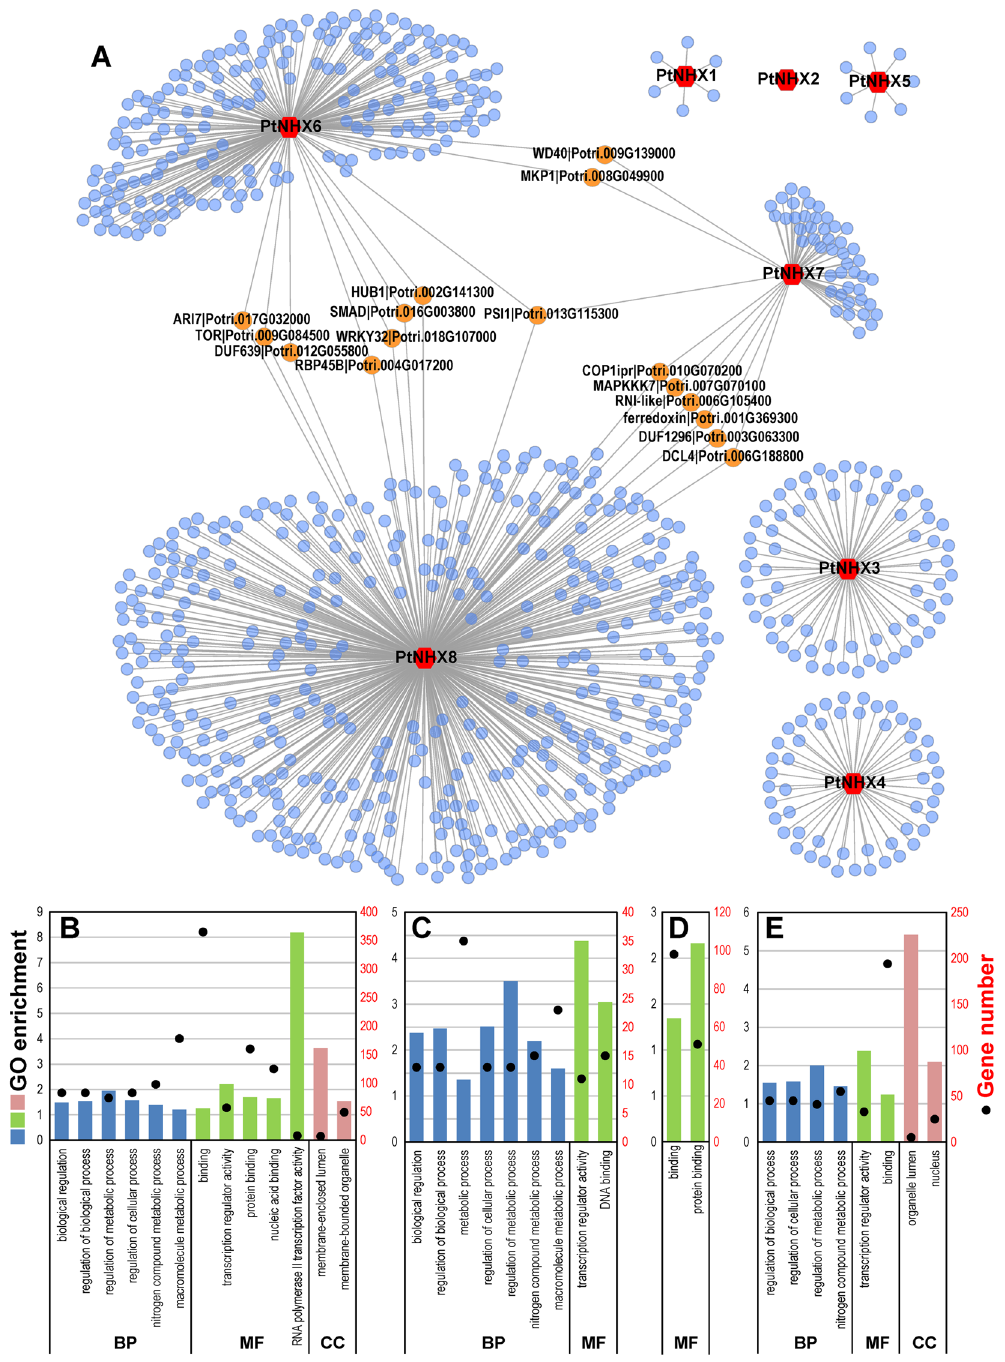
Figure 7. Co-expression network of PtNHX gene family. ( A ) PtNHXs are represented as red hexagon, hub co- expressed genes are represented as orange nodes. Partial results of GO enrichment and enriched gene number of all the genes co-expressed with the eight PtNHXs ( B ), PtNHX3 ( C ), PtNHX6 ( D ), and PtNHX8 ( E ) were shown. Details of GO enrichment are listed in Fig. S9. BP, biological process; MF, molecular function; CC, cellular